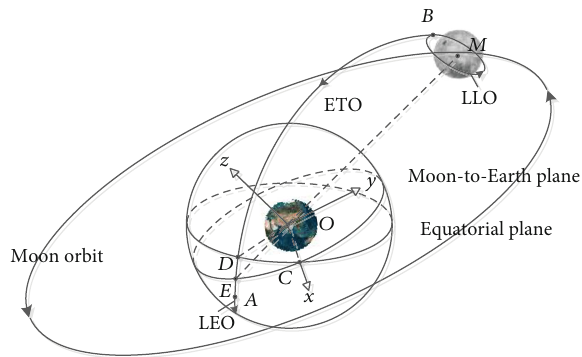
Figure 4: Sketch of ETO in the Earth-centered Moon-to-Earth plane coordinate